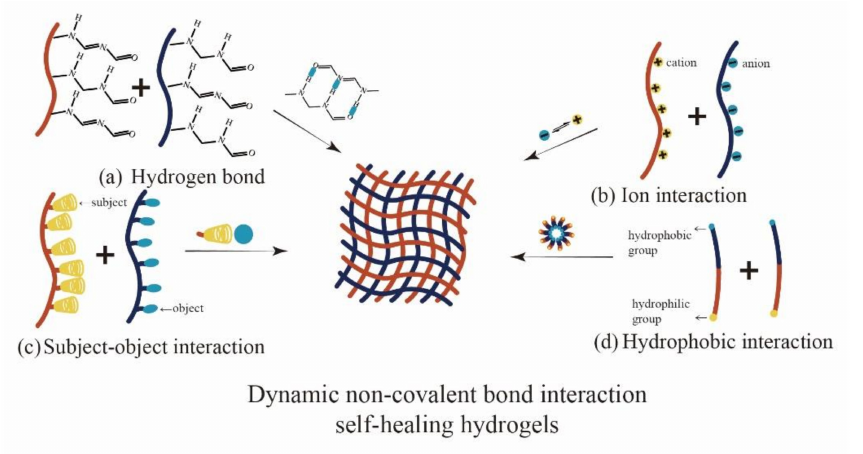
Figure 2. Self-healing hydrogels based on dynamic non-covalent bond interactions: ( a ) Hydrogen bond interaction; ( b )Ioninteraction(metalcoordination); ( c )subject-objectinteraction; ( d